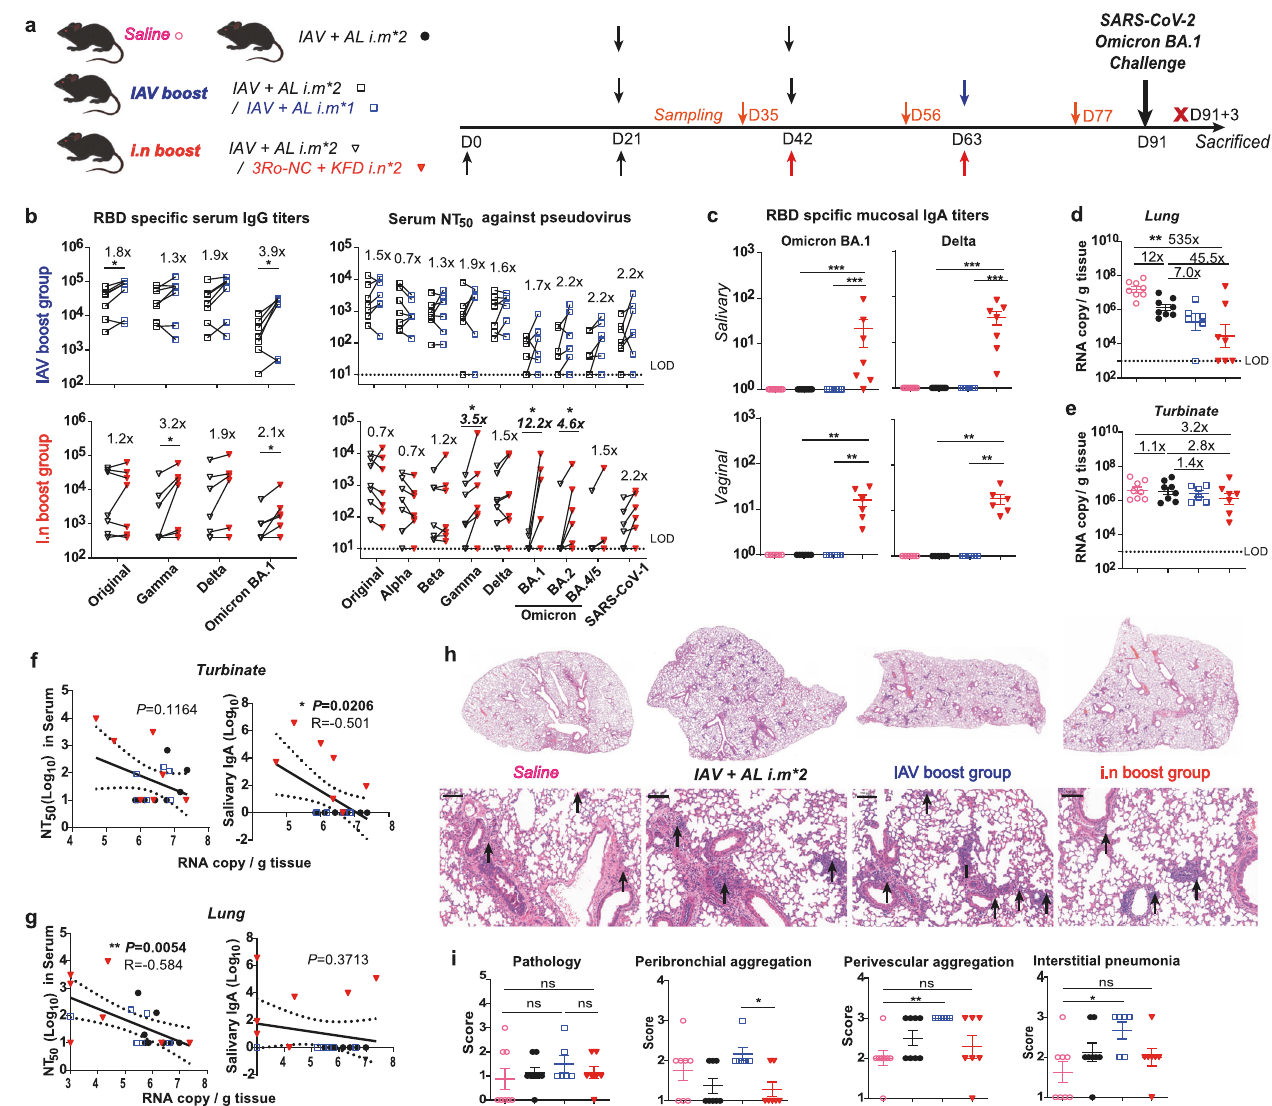
Fig. 1 Protection ef fi cacy of boosts against SARS-CoV-2 variant Omicron infection. a Diagram scheme of immunization and virus challenge. Brie fl y, 12 – 16 weeks old hACE2 transgenic mice were divided into 4 groups: unimmunized saline (8 mice), 2-dose IAVs immunized (8 mice), 2-dose IAVs immunized followed by intranasal boost with 2-dose 3Ro-NC plus KFD ( i.n boost group , 7 mice) or intramuscular boost with 1-dose IAV ( IAV boost group , 6 mice). At day 91, all mice were challenged by the SARS-CoV-2 BA.1 strain and sacri fi ced at day 3 post infection. b RBD-speci fi c serum IgG and neutralization antibody titers of serum against pseudo-typed virus, before and post boost. c Salivary and vaginal IgA post last immunization. d , e qPCR tested RNA copies of SARS-CoV-2 RBD in lung and turbinate. f , g Correlation of RNA copies with Omicron BA.1 RBD-speci fi c salivary IgA and neutralizing titers (dotted lines, 95% con fi dence interval). h Lung sections stained by Hematoxylin and eosin (H&E) (Arrow, in fl ammatory cell in fi ltration; Scale bars, 100 µm). i Pathological scores, in fi ltration scores of immunocyte aggregation around bronchioles, pulmonary vessels, and interstitial pneumonia according to the H&E-stained sections. Data are represented as mean ± SEM. Groups were compared using paired t test ( b ), or one-way ANOVA ( c – e and i ). ns not signi fi cant; * P < 0.05; ** P < 0.01; *** P < 0.001. LOD limited of